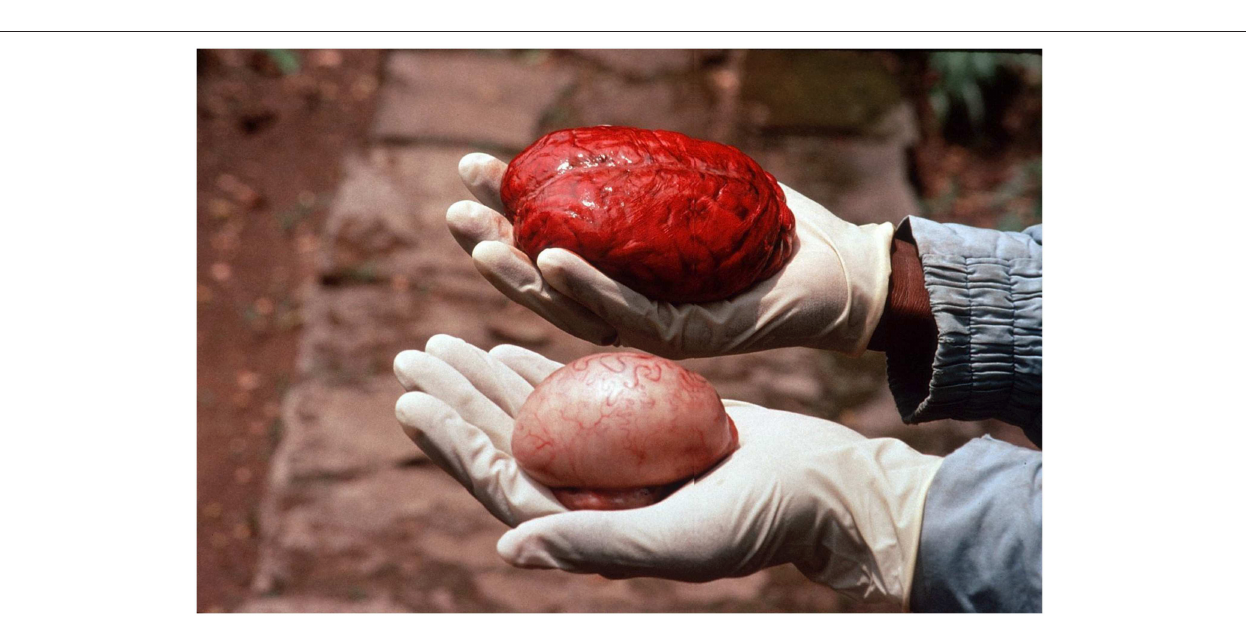
FIGURE 2 | A chimpanzee brain in comparison to a single testis. Photo credit: Martin N.